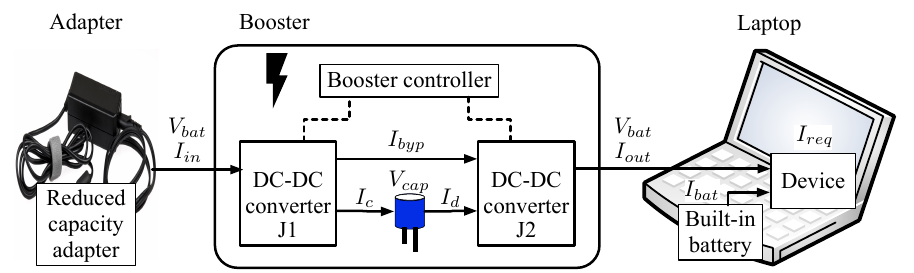
Figure 1. Suggested supercapacitor–battery hybrid